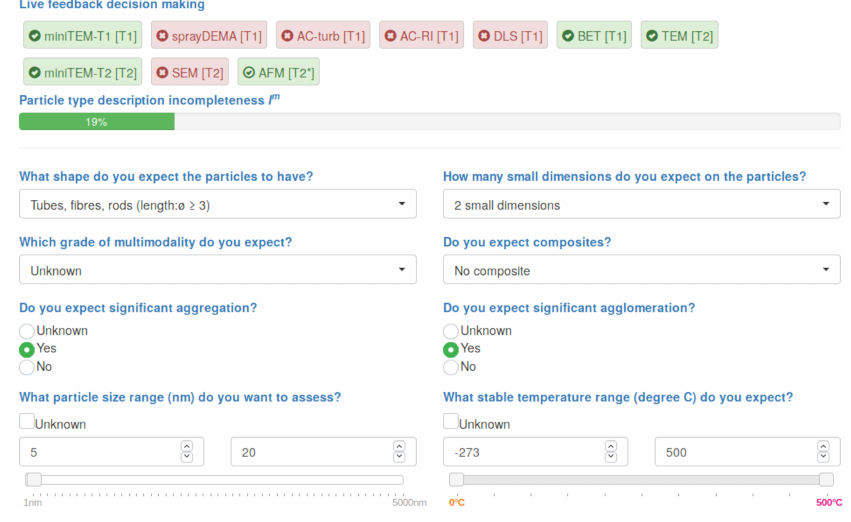
Figure 7. An excerpt of the material categorization scheme (MCS) via which physicochemical particle type properties are described (lower part). Changes in the MCS trigger live feedback on recommendations (upper part): Recommended measurement technique are highlighted green with a check mark, unrecommended are highlighted red with a cross